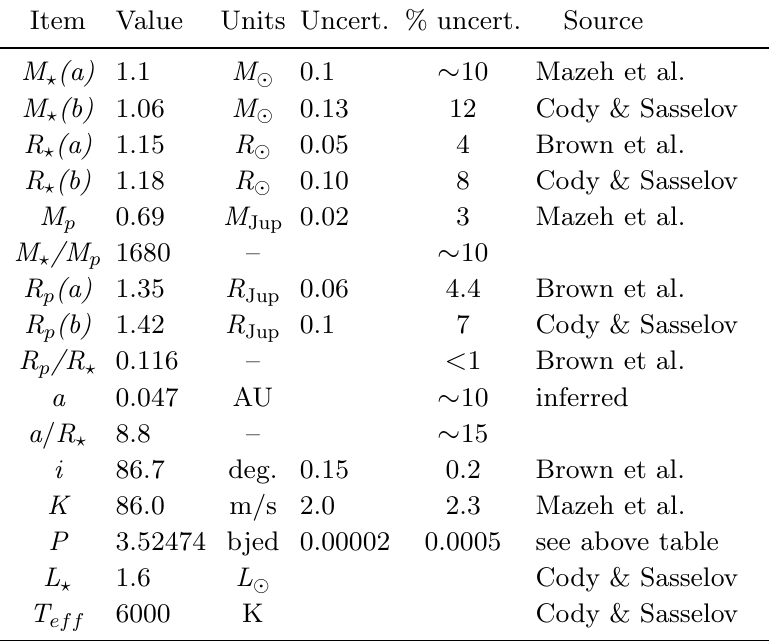
Table 3. A summary of the principal physical properties of the HD 209458 star/planet